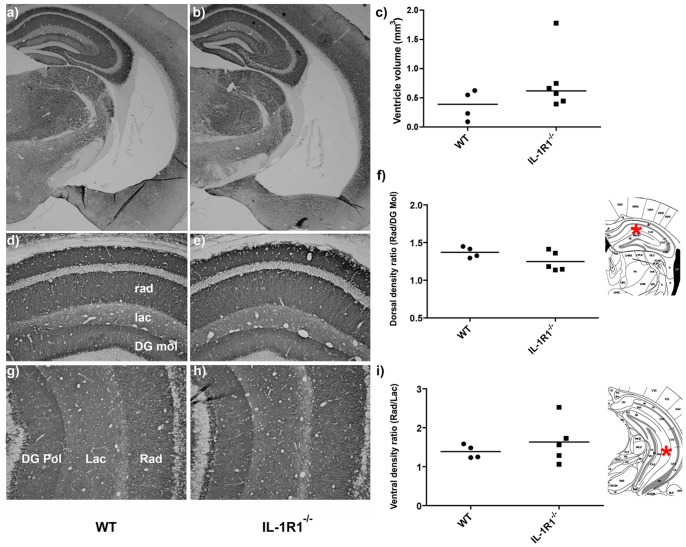
Ventricular volume and synaptic density in WT and IL-1R1−/− mice.(a–c) Representative images of the hippocampus and lateral ventricle of WT (a) and IL-1R1−/− (b) brain. Ventricular volume in WT (n = 4) and IL-1R1−/− mice (n = 6) was assessed using Image J Software (c). Areas were calculated for sections from each animal at 2.0 and 2.3 mm posterior to Bregma and summed and multiplied by the summed section thickness (2×10 µm: 0.02 mm). Data are non-parametric and have been presented as dot plots with median value denoted by the bar. (d–i) Synaptophysin labelling in the dorsal (see inset *) and more ventral hippocampus (approximately −3.0 mm from surface of brain; see inset *) of WT (d, g) and IL-1R1−/− mice (e, h). Synaptic density analysis of the dorsal hippocampus: ratio of stratum radiatum to dentate gyrus molecular (f) and ventral hippocampus ratio of stratum radiatum to stratum lacunosum moleculare (i) for WT (n = 4) and IL-1R1−/− (n = 5).